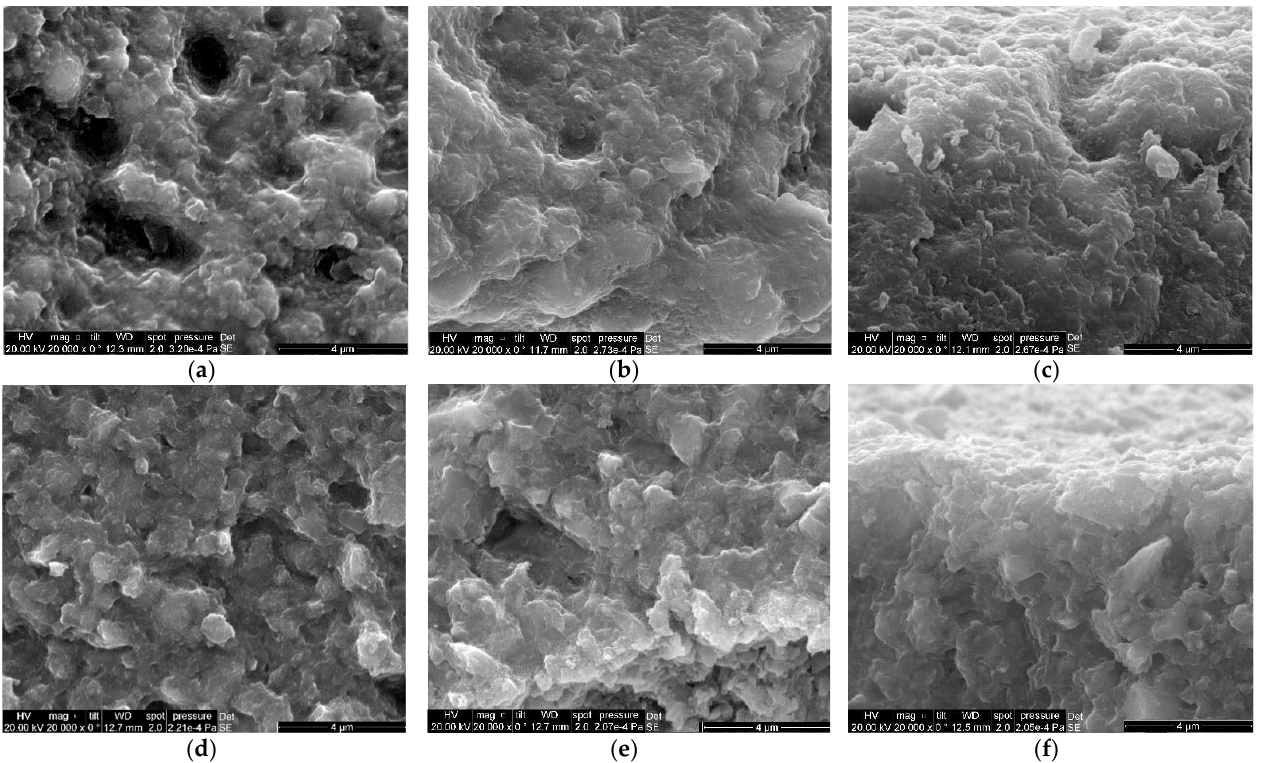
Figure 1. SEM micrographs of the samples: ( a ) Sample 1-the microcomposite, seen in the middle of the section area; ( b ) Sample 1-the side facing the curing lamp; ( c ) Sample 1-the side opposite to the curing lamp; ( d ) Sample 2-the nanocomposite, in the middle of the section area; ( e ) Sample 2-the side facing the curing lamp; ( f ) Sample 2-the side opposite to the curing lamp.